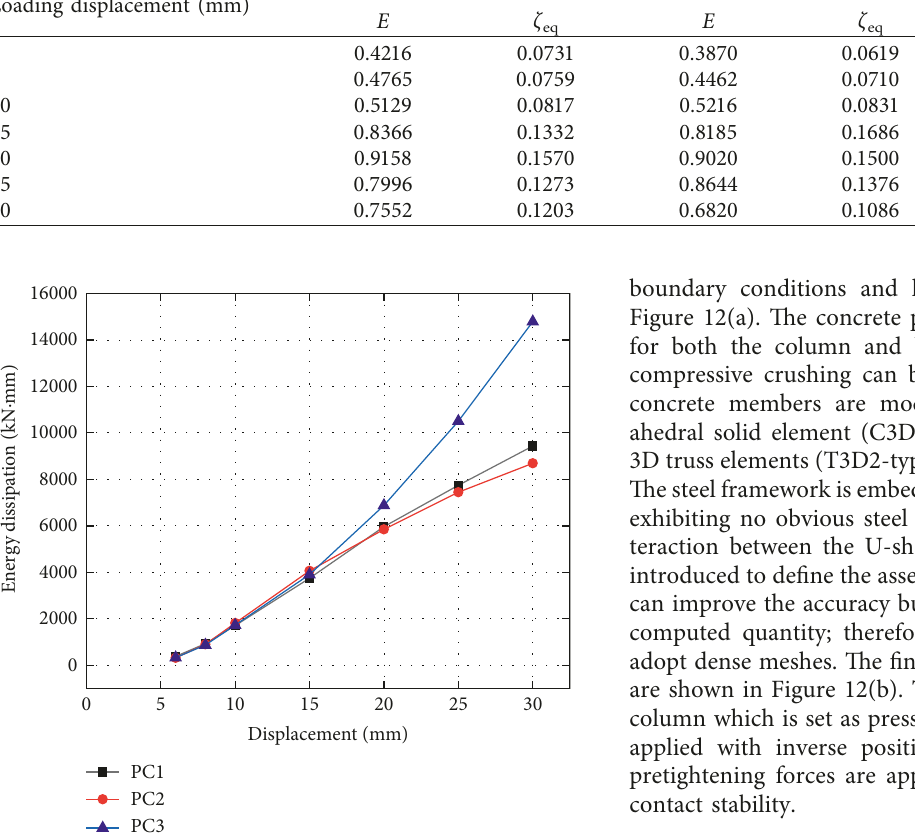
Figure 9: Comparison of cumulative energy